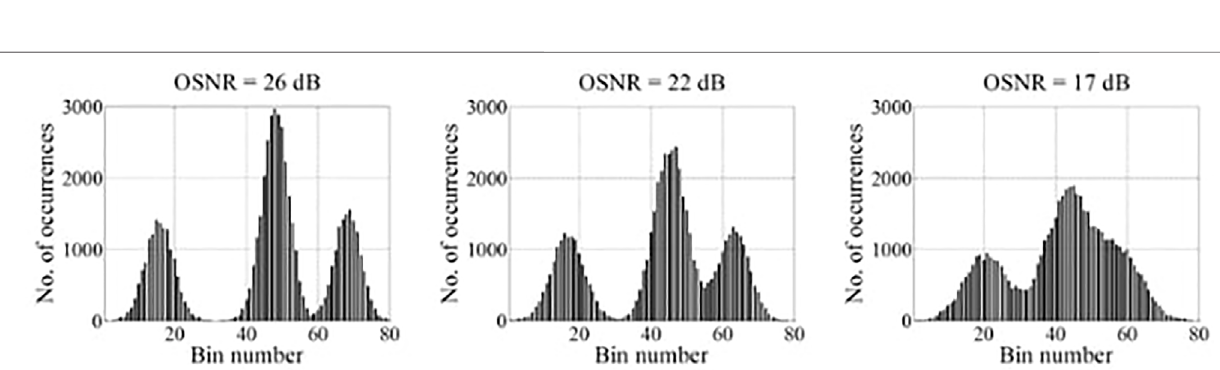
Frontiers in Communications and Networks |